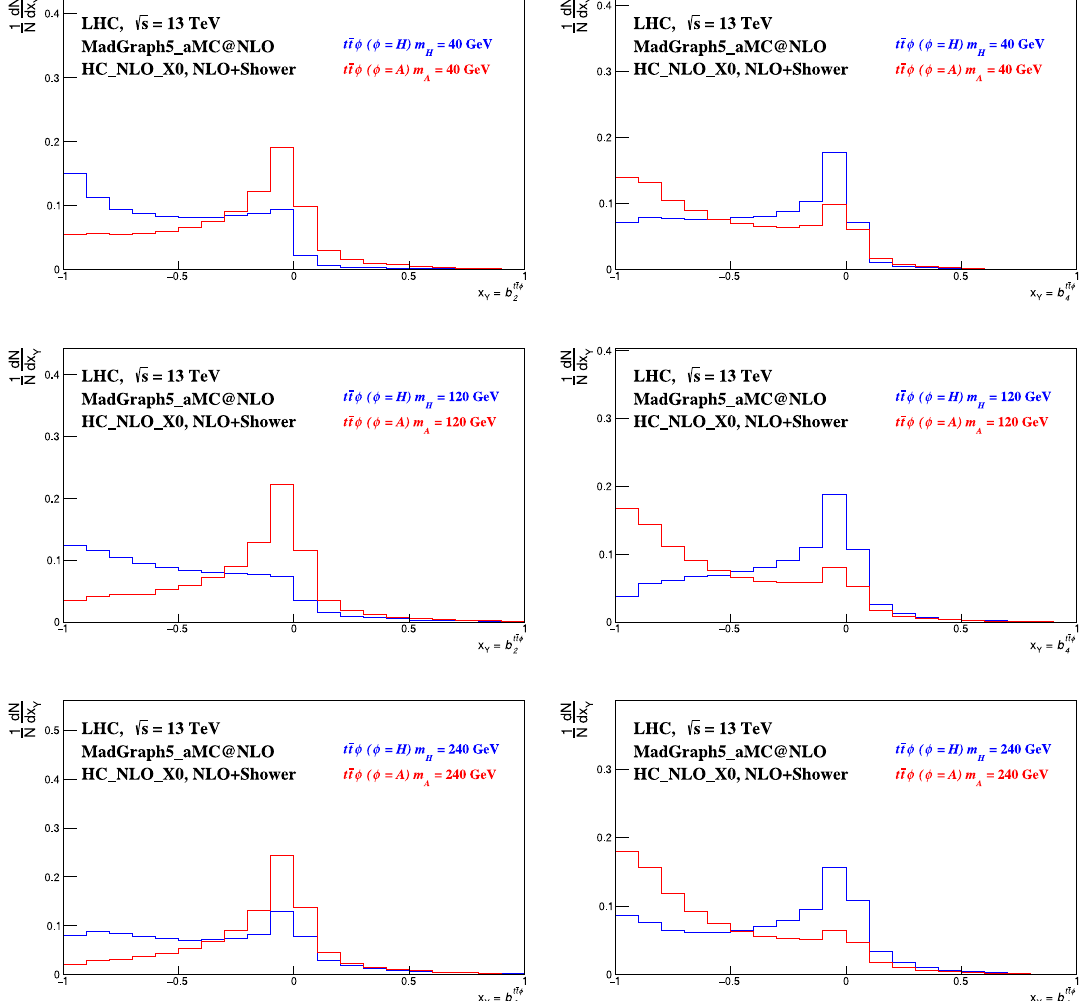
Figure 5. Same as in (cid:12)gure 4, but now the b 2 and b 4 distributions are computed in the centre-of- mass of the t (cid:22) t(cid:30) system.